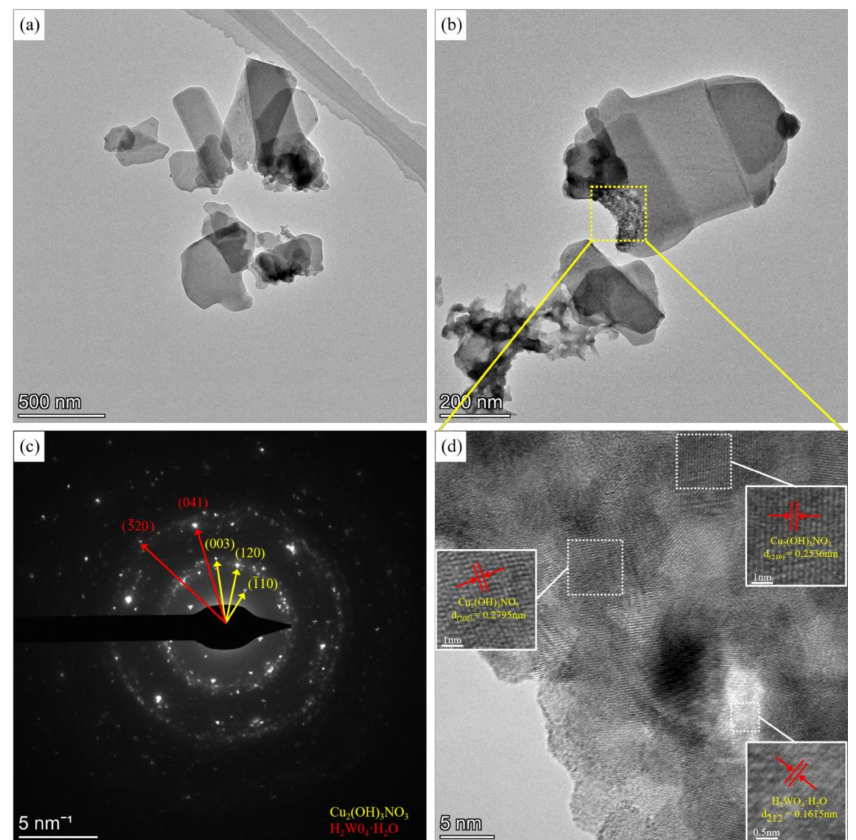
Figure 5. ( a ) and ( b ) TEM images of Cu-20wt%W precursor powders; ( c ) SAED pattern in the location in Figure 5b; ( d ) HRTEM image of the medium yellow area in Figure